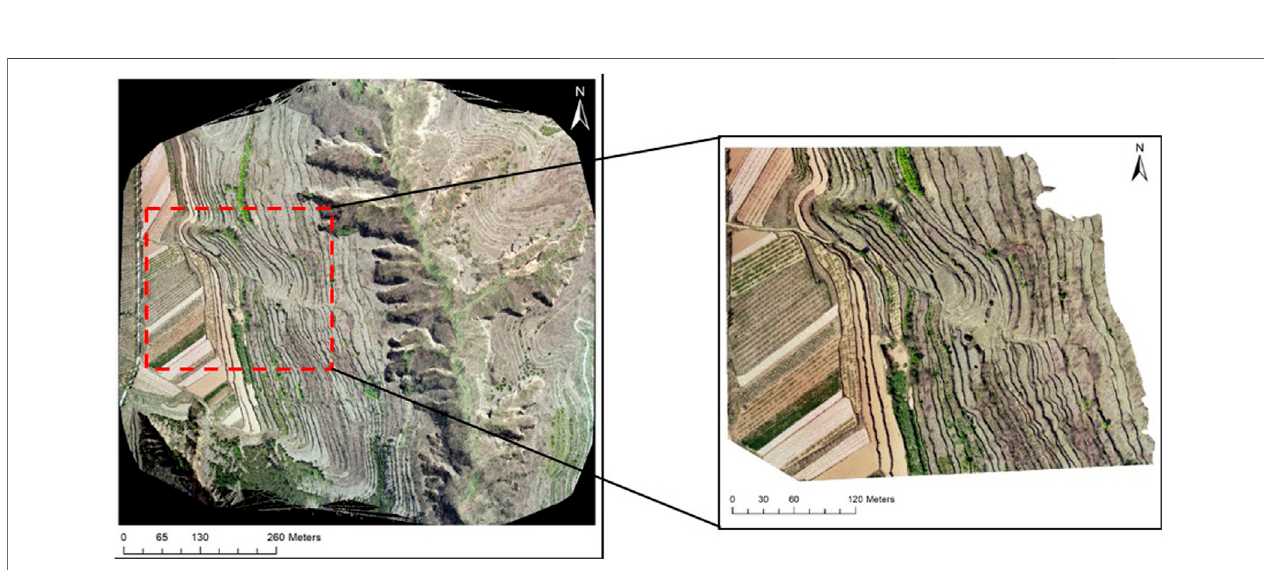
FIGURE 2 | RGB orthomosaic of a sub-catchment in the Wangdong Catchment on the Chinese Loess Plateau and the selected terraced fi eld.